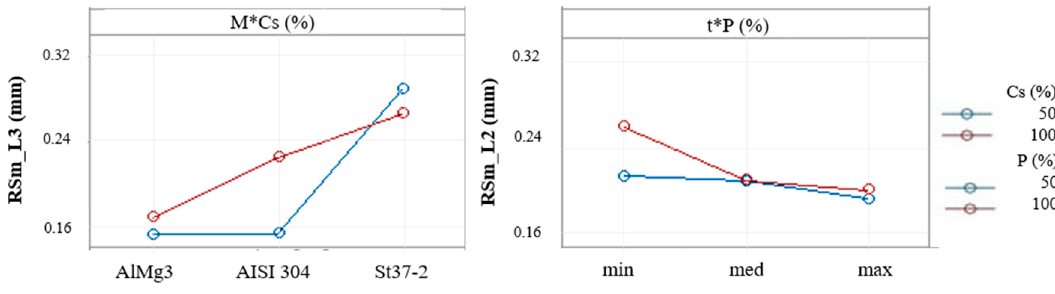
Figure 16. Interaction plot for RSm.